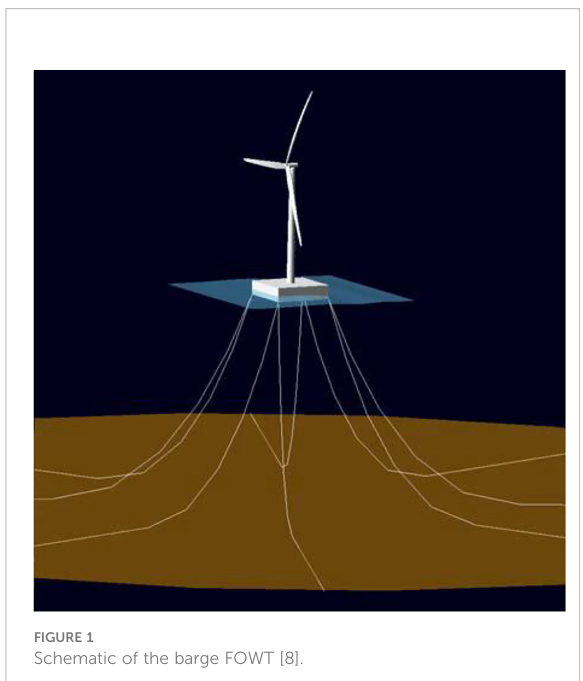
FIGURE 1 Schematic of the barge FOWT [8].